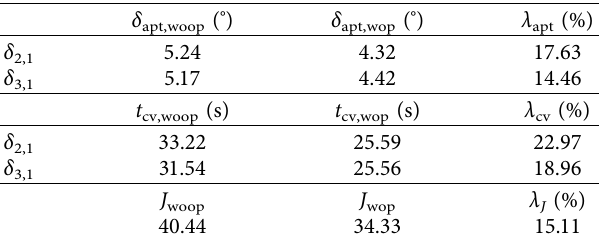
Figure 14: Power angle diference between SGs with and without coordinated optimization to K diference between #2 and #1 SGs. (b) Power angle diference between #3 and #1 SGs. Table 10: Efect analysis of coordinated optimization to the CCC and the